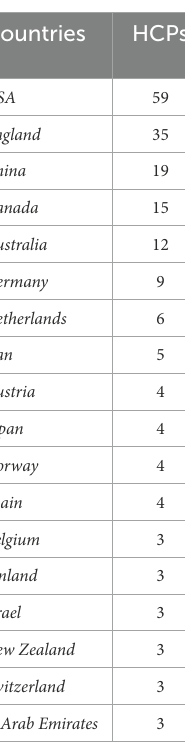
TABLE 4 Top 18 countries with at least 3